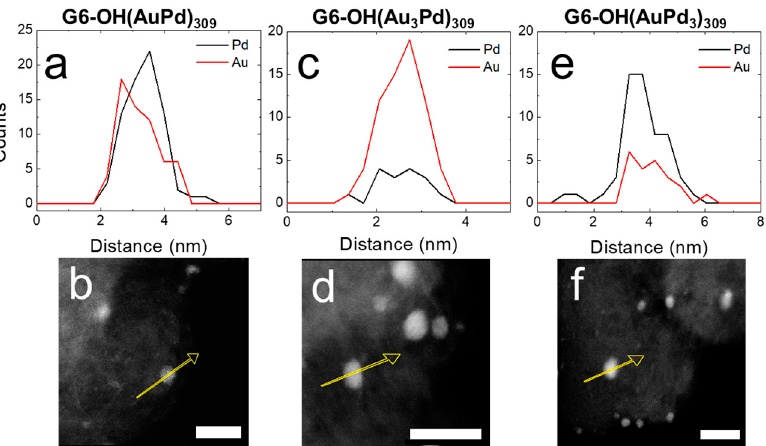
Figure 7. EDS line scans and corresponding ac-STEM micrographs for conductive inks containing ( a , b ) G6-OH(AuPd) 309 ; ( c , d ) G6-OH(Au 3 Pd) 309 ; and ( e , f ) G6-OH(AuPd 3 ) 309 DENs after a 1.0 h EOR CA. CAs were carried out in a N 2 -satd., 1.0 M KOH solution containing 0.50 M ethanol, by holding the electrode potential for 1.0 h at the peak potential of the forward scan of the EOR CV. The yellow arrow on each ac-STEM micrograph corresponds to the x-axis of the EDS line scan. The scale bar is 5.0 nm.